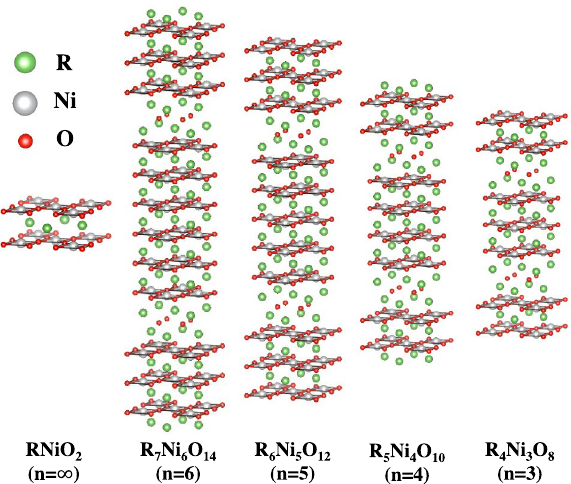
3 6 and n . The common 1 Ni n O 2 n 2 series for n = − = ∞ + + 3 6 = −